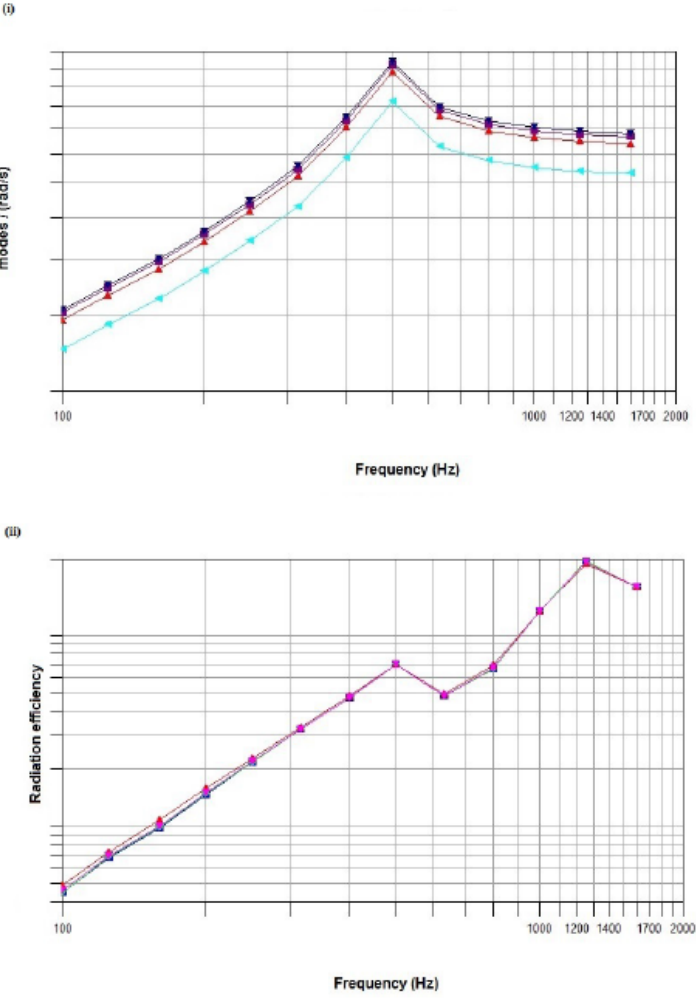
Figure 3. From the top to the bottom: ( i ) modal densities; and ( ii ) radiation efficiency for the statistical energy analysis (SEA) subsystems in the IS01 interstage hybrid